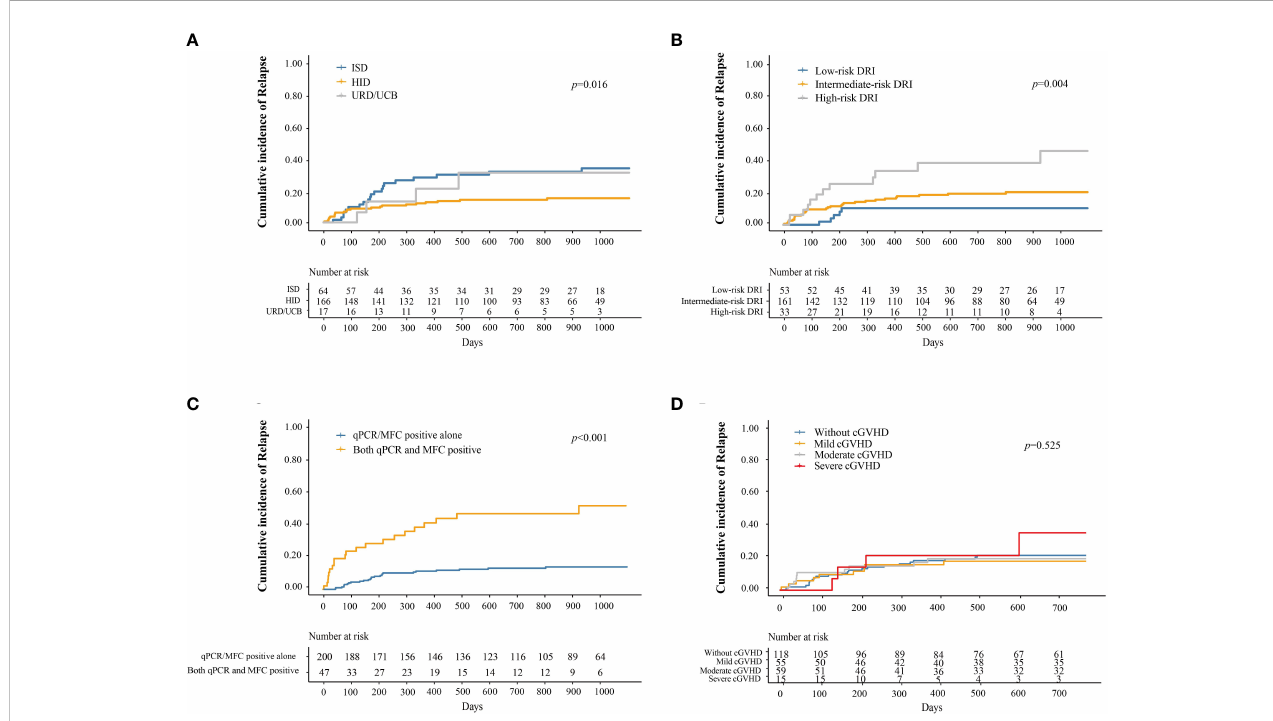
FIGURE 3 Cumulative incidence of relapse after preemptive IFN- a therapy for patients receiving ISD, HID, and URD/UCB transplantation (A) , for patients in the low-, intermediate-, and high-risk DRI groups (B) , for patients with qPCR/MFC positive alone and both qPCR and MFC positive (C) , and for patients without cGVHD, with mild, moderate, and severe cGVHD (D) . IFN- a , interferon- a ; ISD, identical sibling donor; HID, haploidentical donor; URD, unrelated donor; UCB, unrelated cord blood; qPCR, quantitative polymerase chain reaction; MFC, multiparameter fl ow cytometry; DRI, disease risk index; cGVHD, chronic graft-versus-host